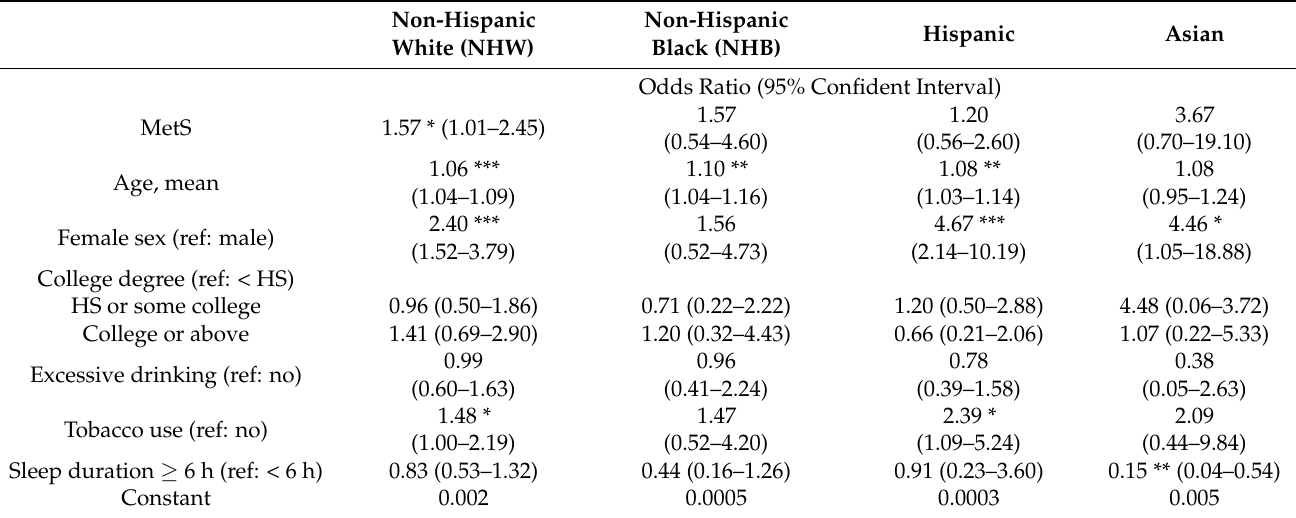
Table 2. Binary logistic regression results of the association between cancer and MetS with covariates, NHANES